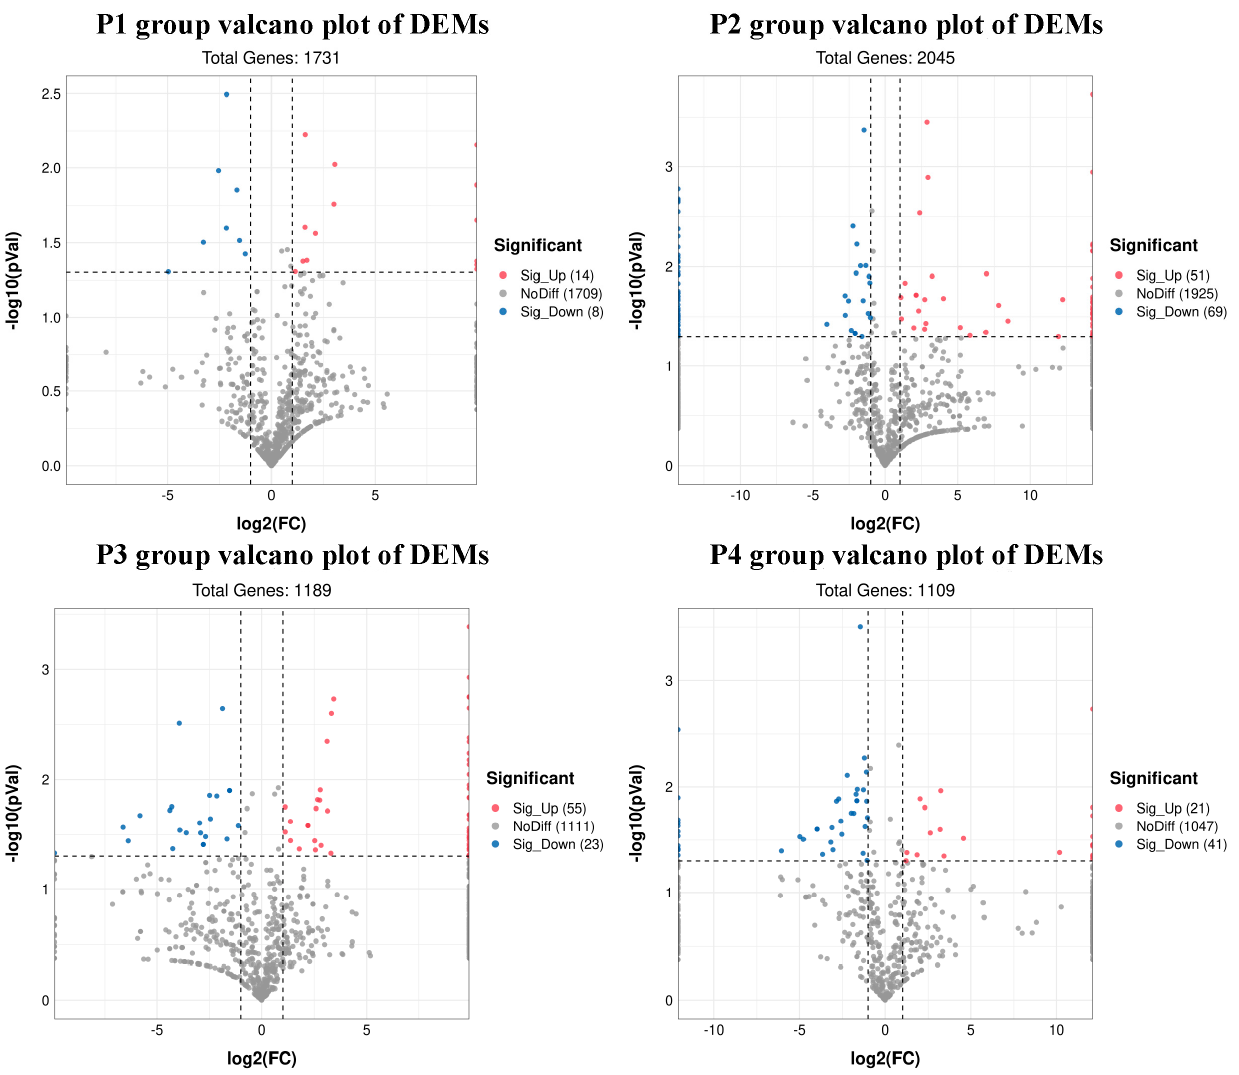
Figure 3. Volcano plots showing differentially expressed miRNAs (red and blue dots).